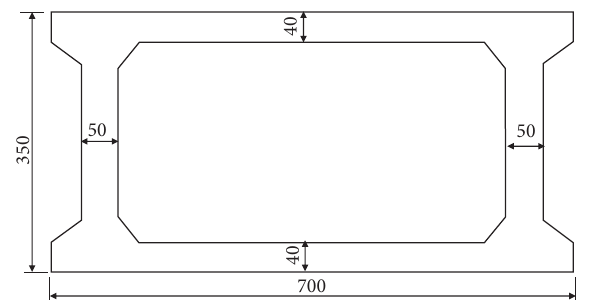
Figure 8: Standard section of the arch (units: cm).